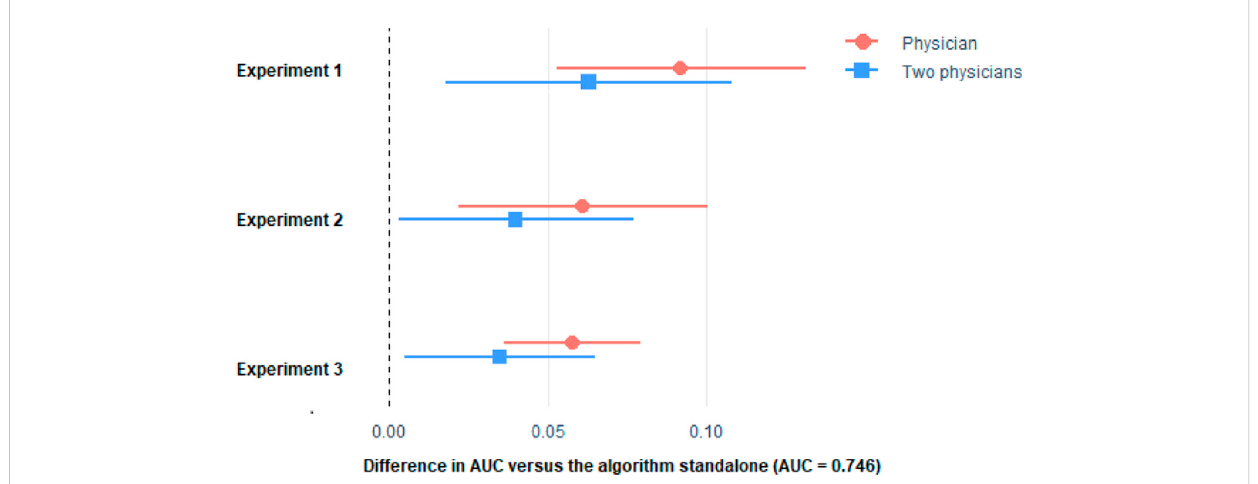
FIGURE 4 Difference in AUC with respect to the algorithm of the strati fi cation made by the physicians only, and the mean of two physicians. Horizontal lines represent the 95% CI of the difference. See Supplementary Table SB of the Appendix for the procedure to build the 95% CI. Please see comment on previous fi gure regarding footnote.